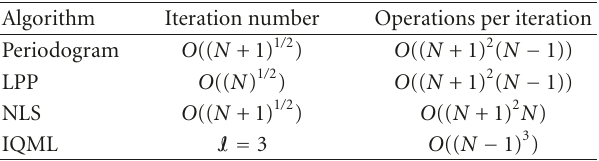
Table 2: Complexity comparison of di ff erent algorithms. Algorithm